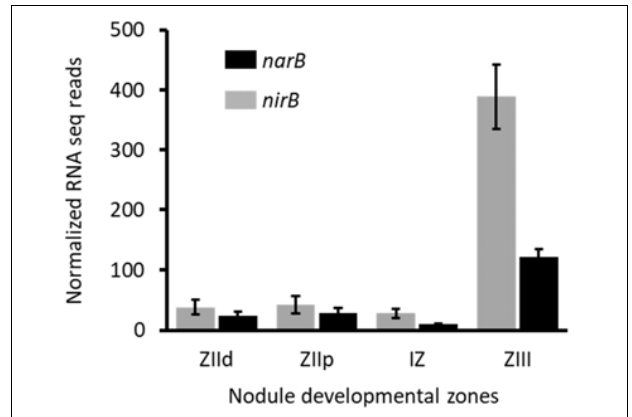
FIGURE 6 | Expression level of nirB and narB genes in nodules. Data shown on this figure are extracted from the work of Roux et al. (2014) (https://iant.toulouse.inra.fr/symbimics). They represent the RNA–seq analysis of bacterial transcripts of narB (black) and nirB (gray) obtained from laser–dissected M. truncatula nodules occupied by a WT S. meliloti strain. ZIId, infection zone, distal part; ZIIp, infection zone, proximal part; IZ, interzone; ZIII, nitrogen fixation